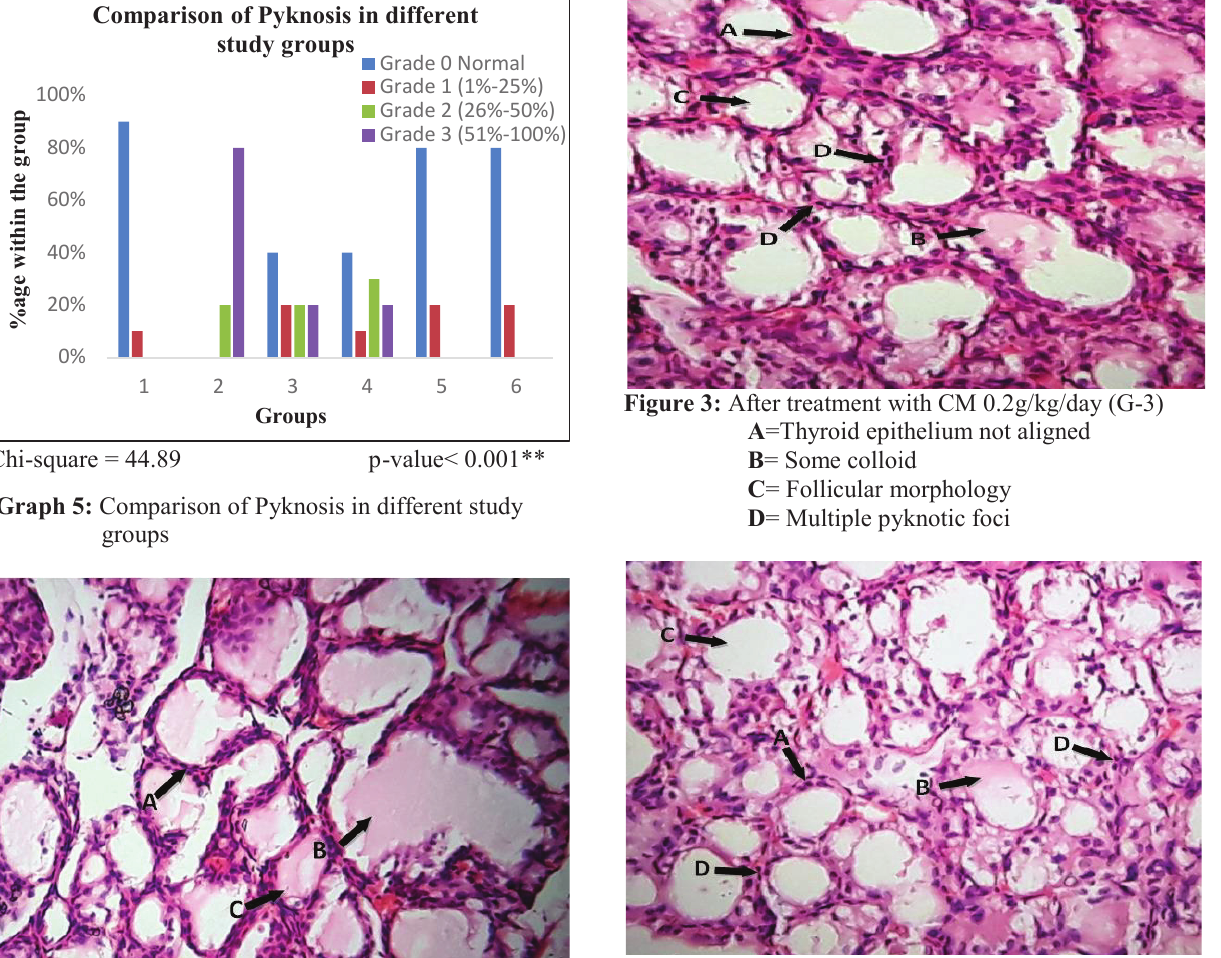
Figure 4: After administering WS 1.4g/kg/day (G-4)